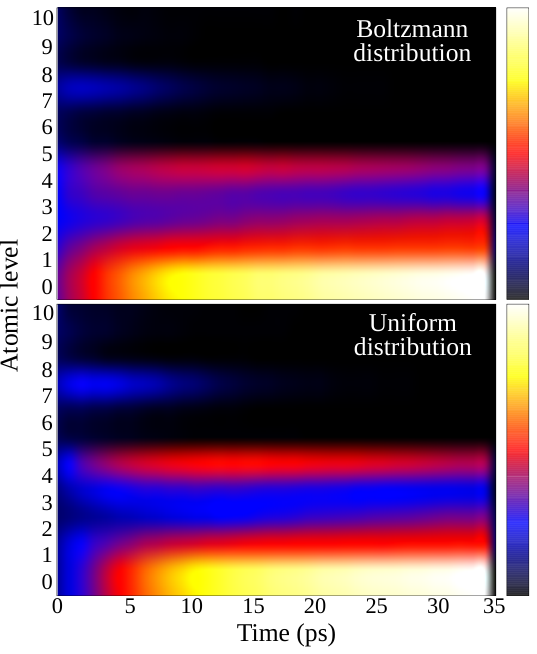
Figure 3. Monte-Carlo simulation of Na-like atomic-state distri- butions for Fe ions, showing an initial Boltzmann ( T = 100eV) vs uniform distribution. The y axis shows the energy-ordered level index. The temperature scale is set relative to the most in- tense population on the plot. Higher-excited states, which feed the lower states, are included in these calculations but not shown. Note that due to binning and fast transitions, the t = 0 distribution does not show the true initial distribution